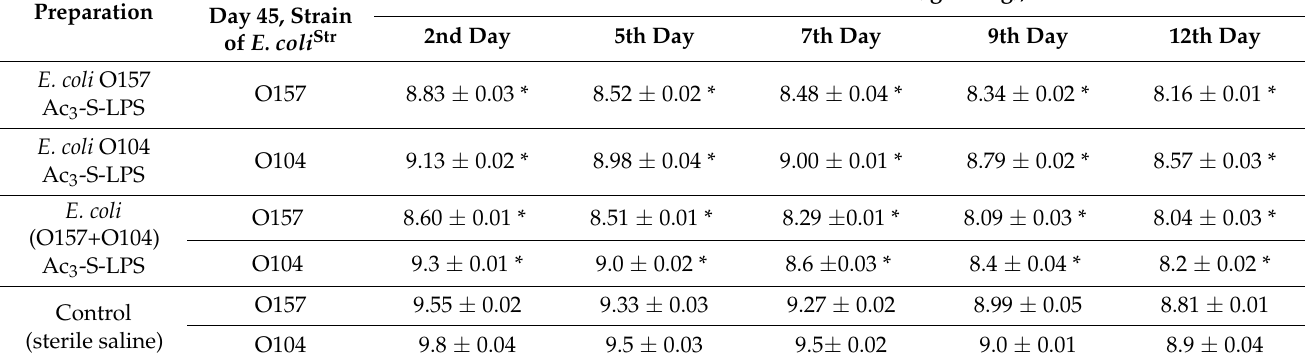
Table 2. E. coli (O157 + O104) Ac 3 -S-LPS di-vaccine and its individual components reduce bacterial counts in the feces of mice intragastrically inoculated with homologous STEC strains. BALB/c mice (10 per group) were immunized i.p. three times with 10-day intervals with 250 µ g of each Ac 3 -S-LPS E. coli O157 or E. coli O104 antigen or with 500 µ g (250 µ g + 250 µ g) of di-vaccine and intragastrically challenged with 1 × 10 9 CFU/mouse of homologous STEC strains resistant to streptomycin ( E. coli O157 Str and E. coli O104 Str ). The decreases in bacterial counts in fecal samples of triple immunized mice compared to control group were statistically significant (* p < 0.05,